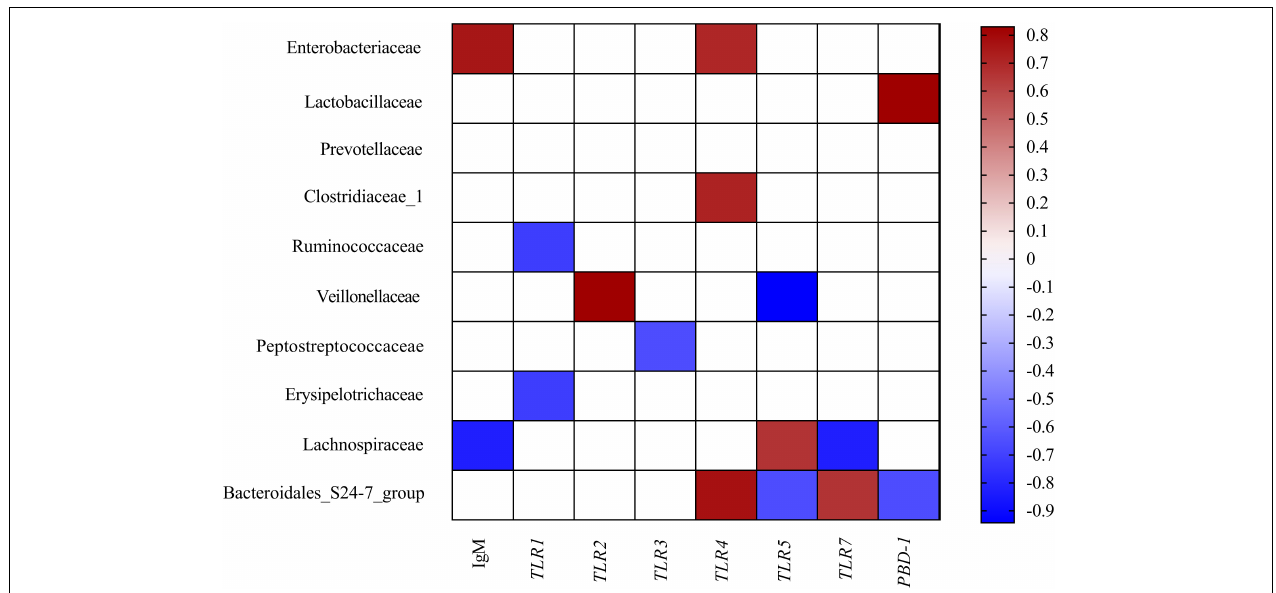
FIGURE 3 | Correlation analysis between colonic microbial composition (relative abundance of family higher than 0.1%) and serum immunity and genes related to gut immunity that were significantly affected by FF treatment in the colon of pigs. The color represents a significant correlation ( P < 0.05), and the intensity of the colors represents the degree of association. Red represents significant positive correlation and blue represents significantly negative correlation ( n =